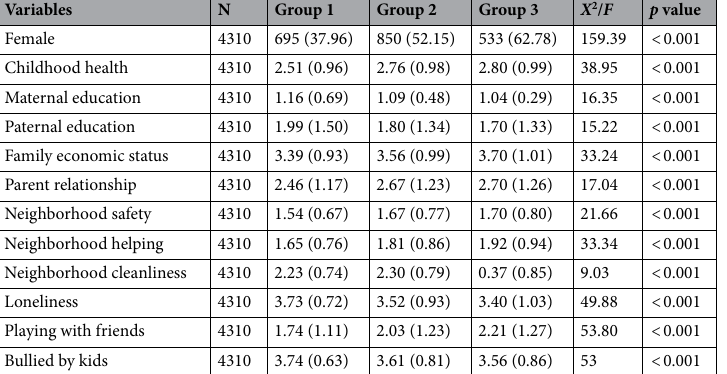
Table 3. Childhood characteristics of older adults on three disability trajectory groups. Continuous variables are shown as mean (SD) and categorical variables are shown as frequency (%).